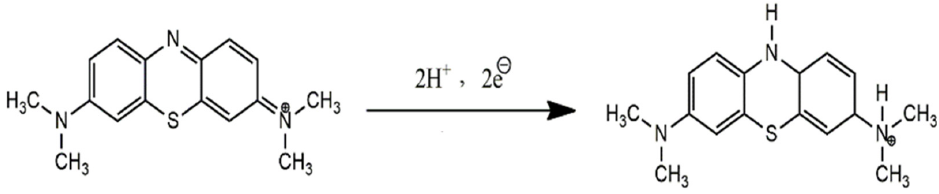
Scheme 1. Proposed oxidation mechanism of MB at the NH 2 - f MWCNTs/GCE.